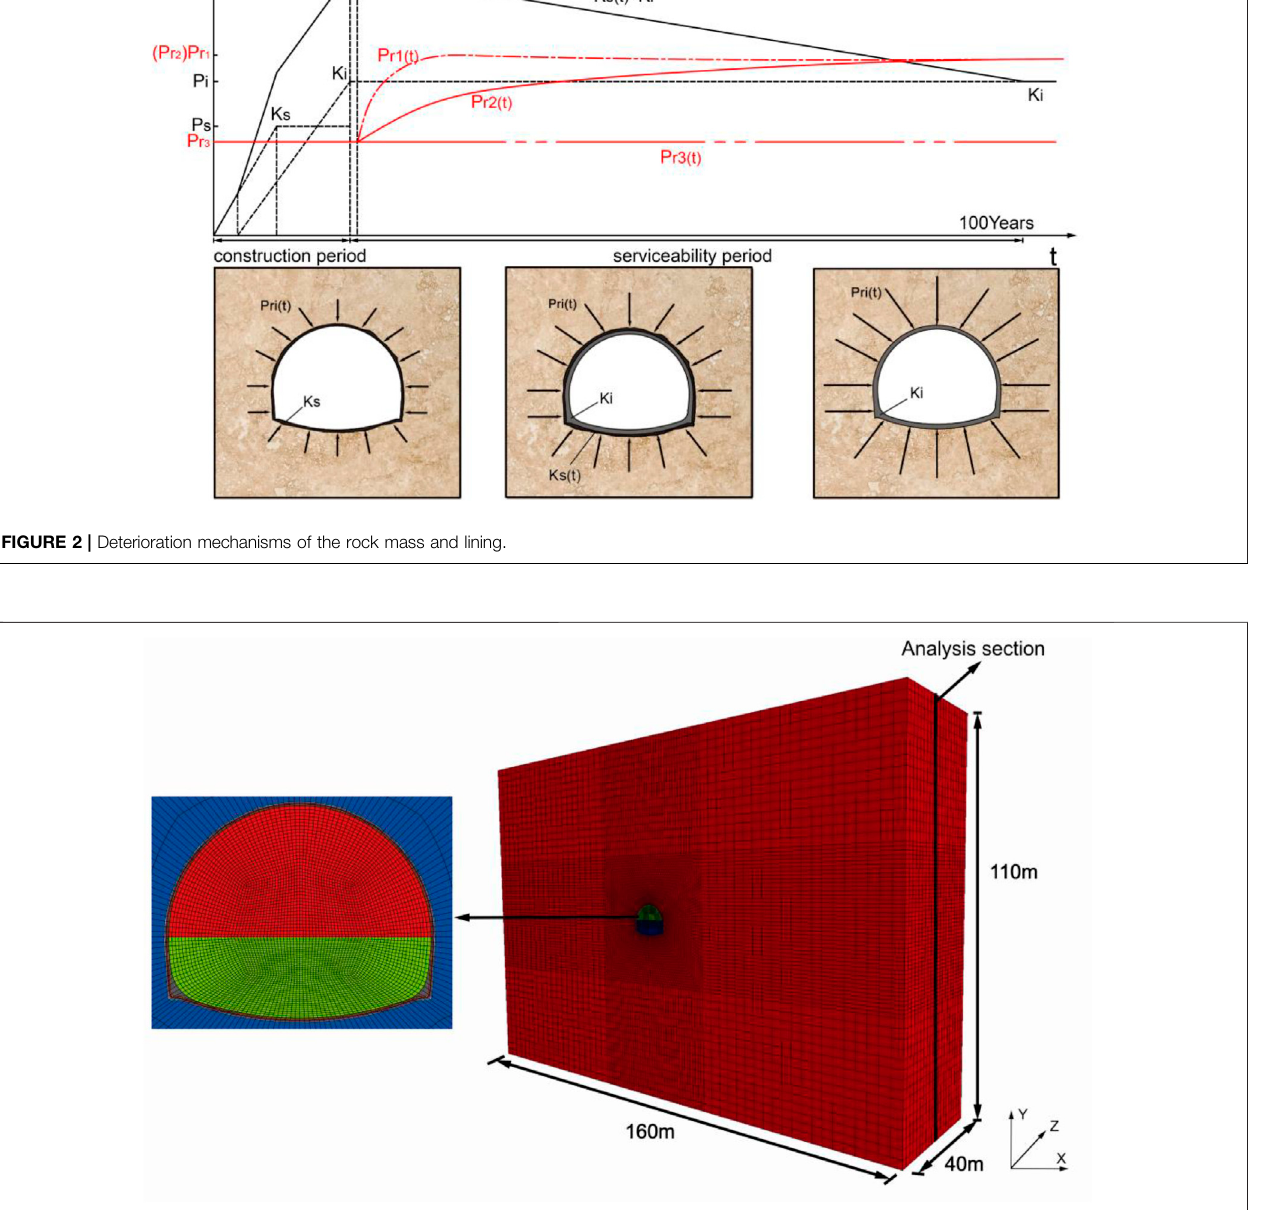
FIGURE 3 | Tridimensional fi nite difference